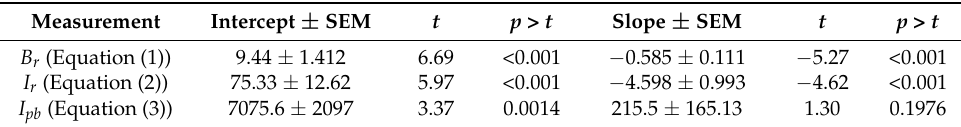
Table 4. Intercepts and slopes ( ± SEM) for regression equations (all values × 10 − 3 ) for regression equations fitting the models in Equations (1)–(3) for 25, 50, and 100 adult C. maculatus hermetically enclosed in 500 mL and 1000 mL hermetic storage